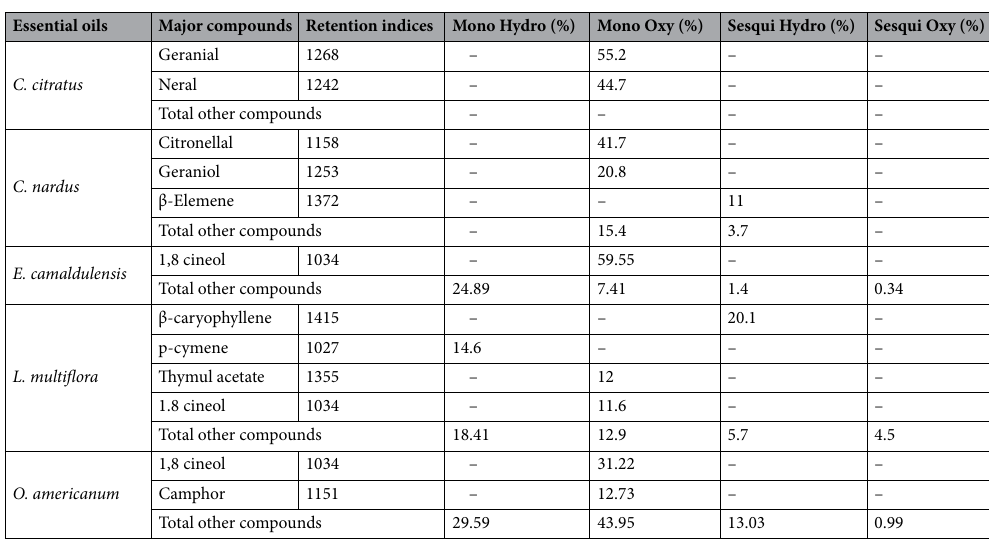
Table 2. Major compounds of the 5 essential oils tested on adults of Anopheles gambiae. Mono : monoterpenes ; Sesqui : sesquiterpenes, Hydro : Hydrocarbon and oxy :